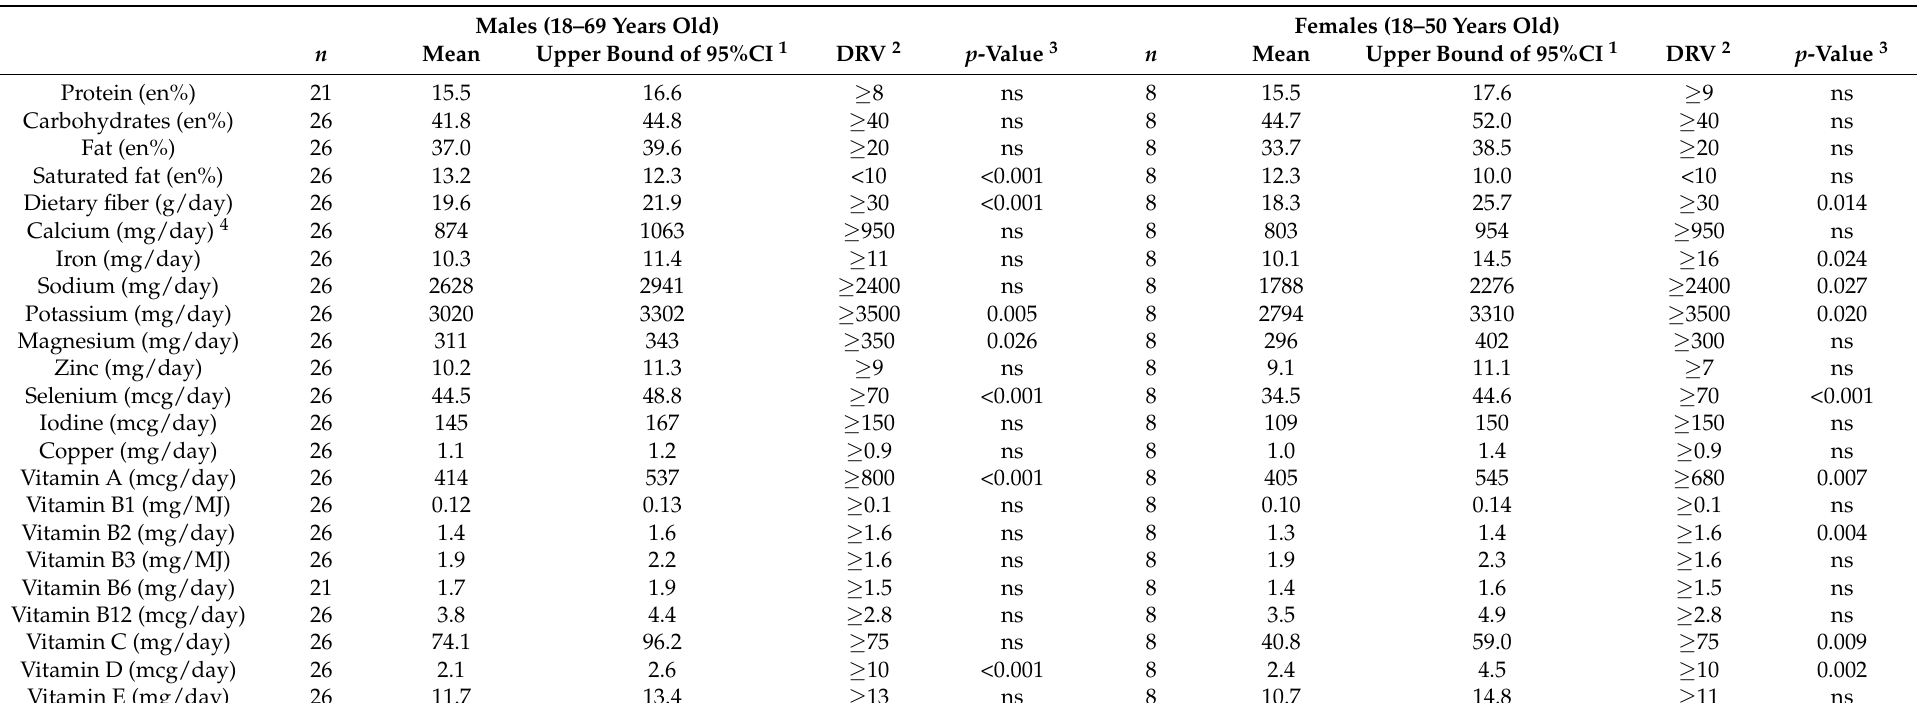
Table 2. Comparison between habitual diet at baseline and Dutch Dietary Reference Values (DRV) for males 18–69 years and females 18–50 years [24–26], except for protein and vitamin B6 where different DRVs apply for 18–50-year-old and >50-year-old males and comparisons are only presented for males and females 18–50